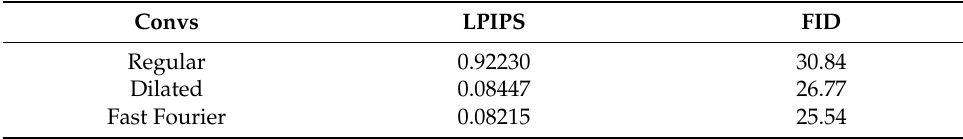
Table 4. Effects of different